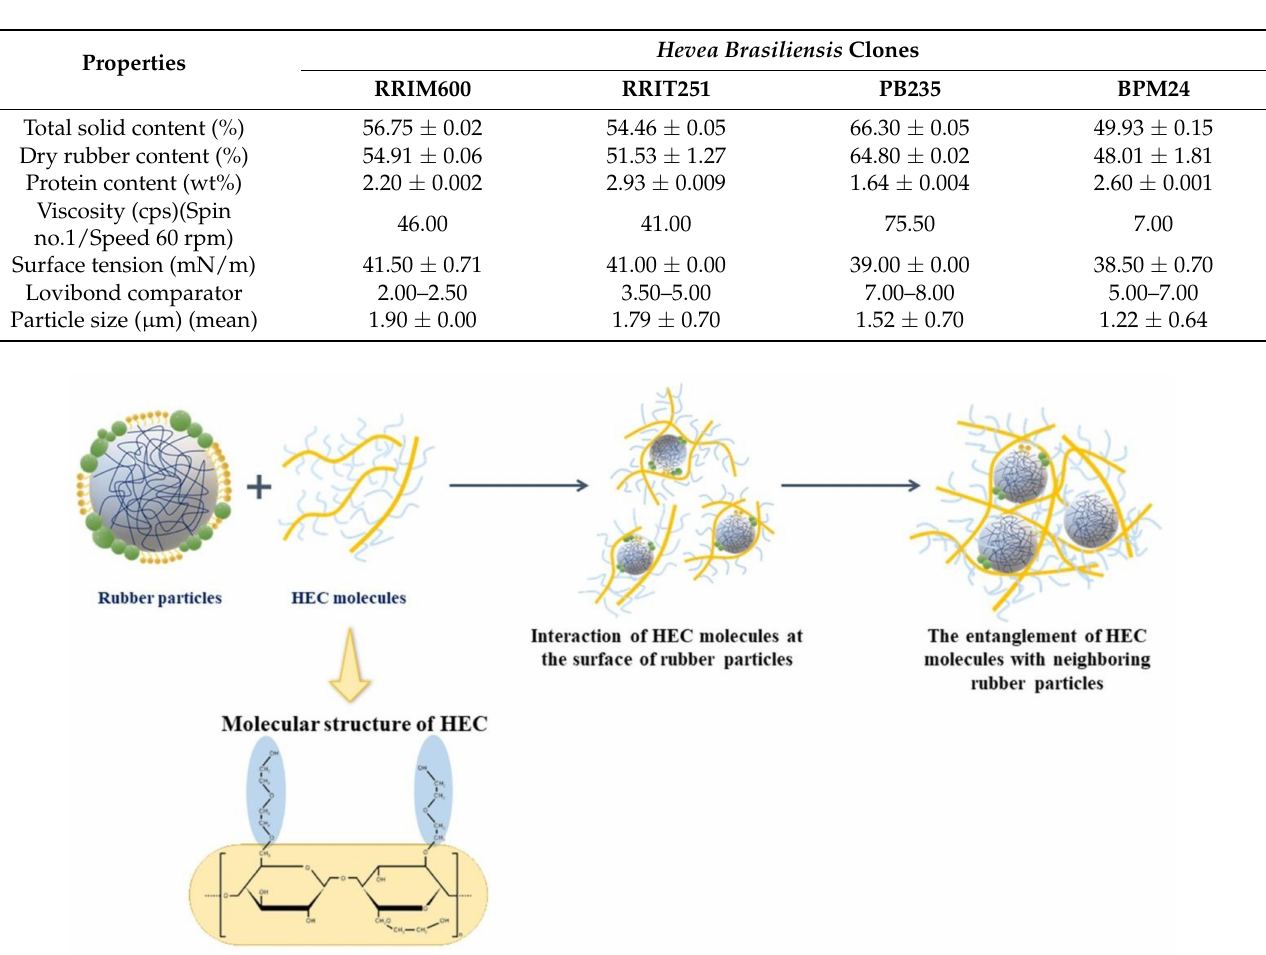
Figure 6. Proposed model for the structures of creamed latex with the incorporation of HEC molecules at the surface of rubber particles.